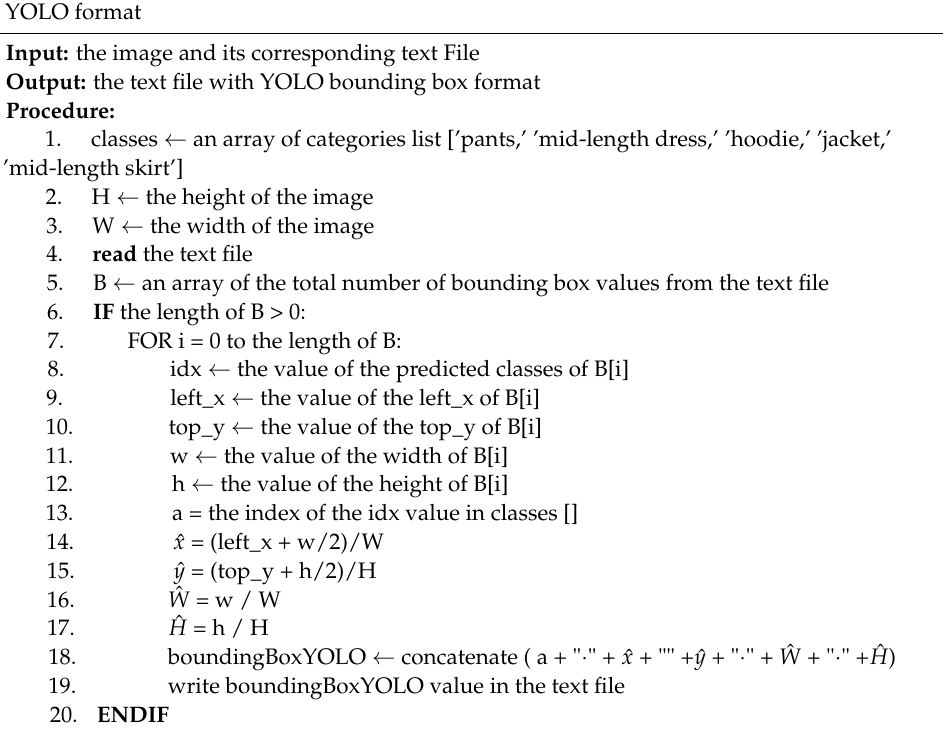
Algorithm 1 The pseudocode of pseudo-labeling to change from detection output format